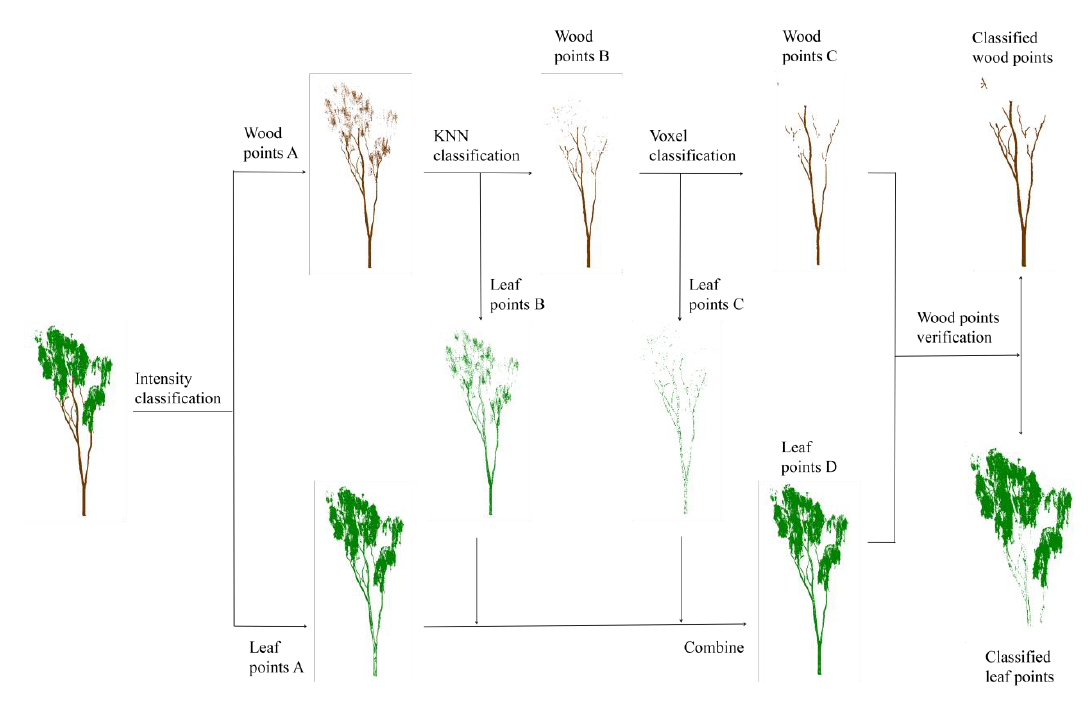
Figure 10. Schematic diagram of classification process of tree 5. Table 3. The number of wood points and leaf points in the classification process of tree 5.